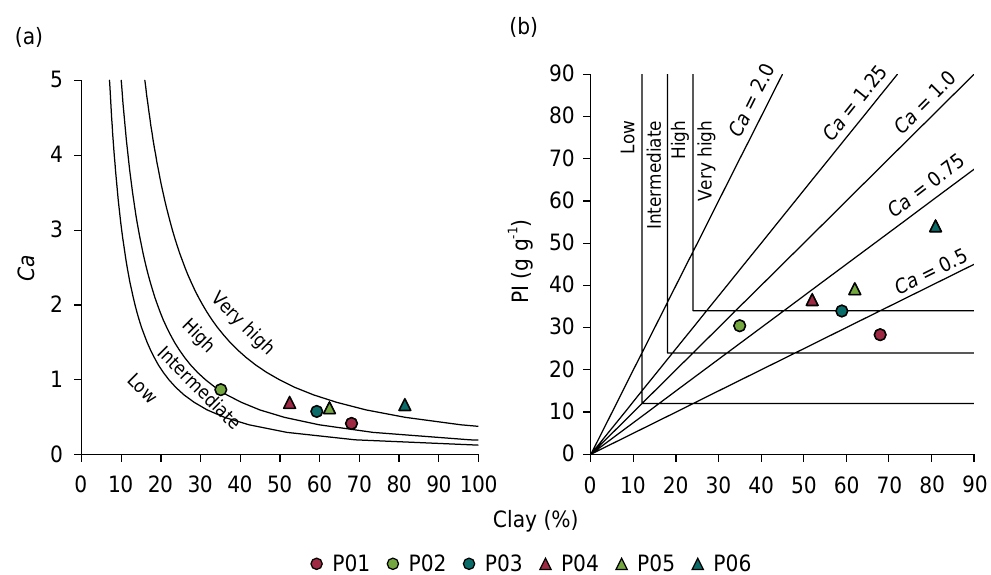
Figure 4. Classification of soil expansion potential based on charts proposed by (a) Seed et al. (1962) and (b) Carter and Bentley (1991) ( Ca = clay